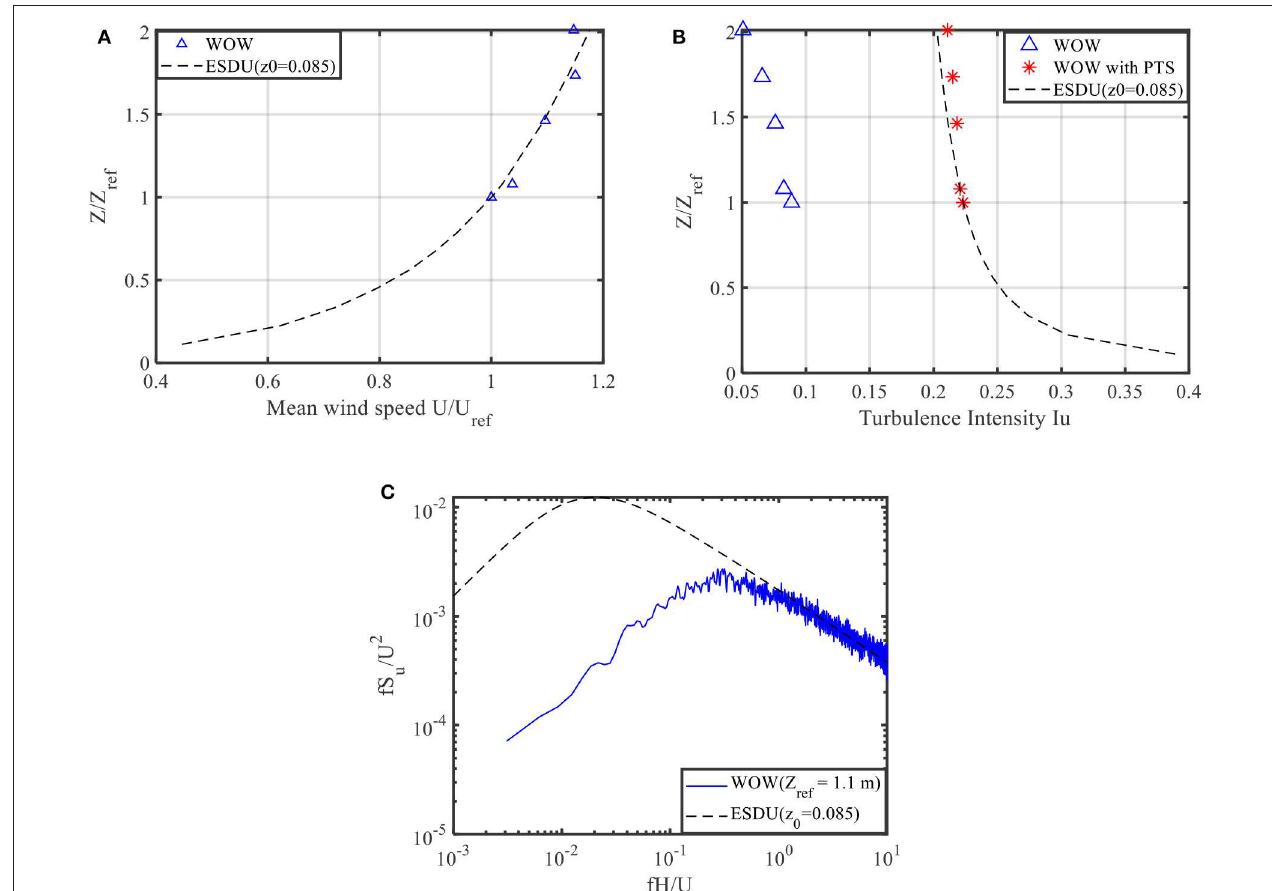
FIGURE 3 | Comparison between WOW and ESDU. (A) Mean wind speed profile. (B) Turbulence intensity profile (C) Power spectral density